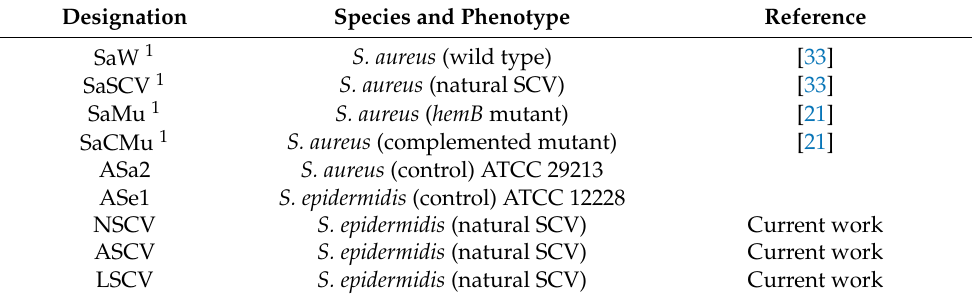
Table 2. SCV strains and controls used within the